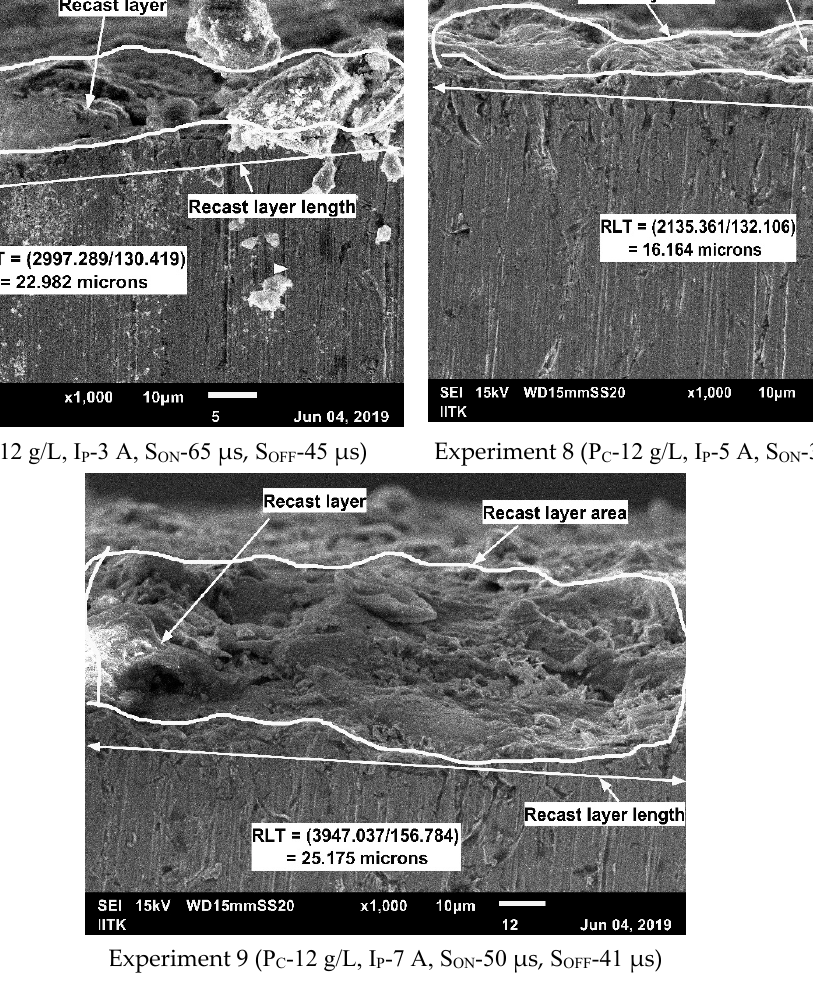
Figure 4. Recast Layer for L9 different experimental runs. Table 6. ANOVA for